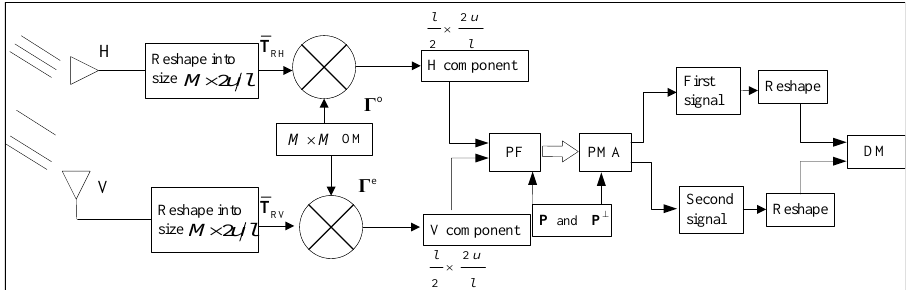
Figure 3. Signal processing on the receiver